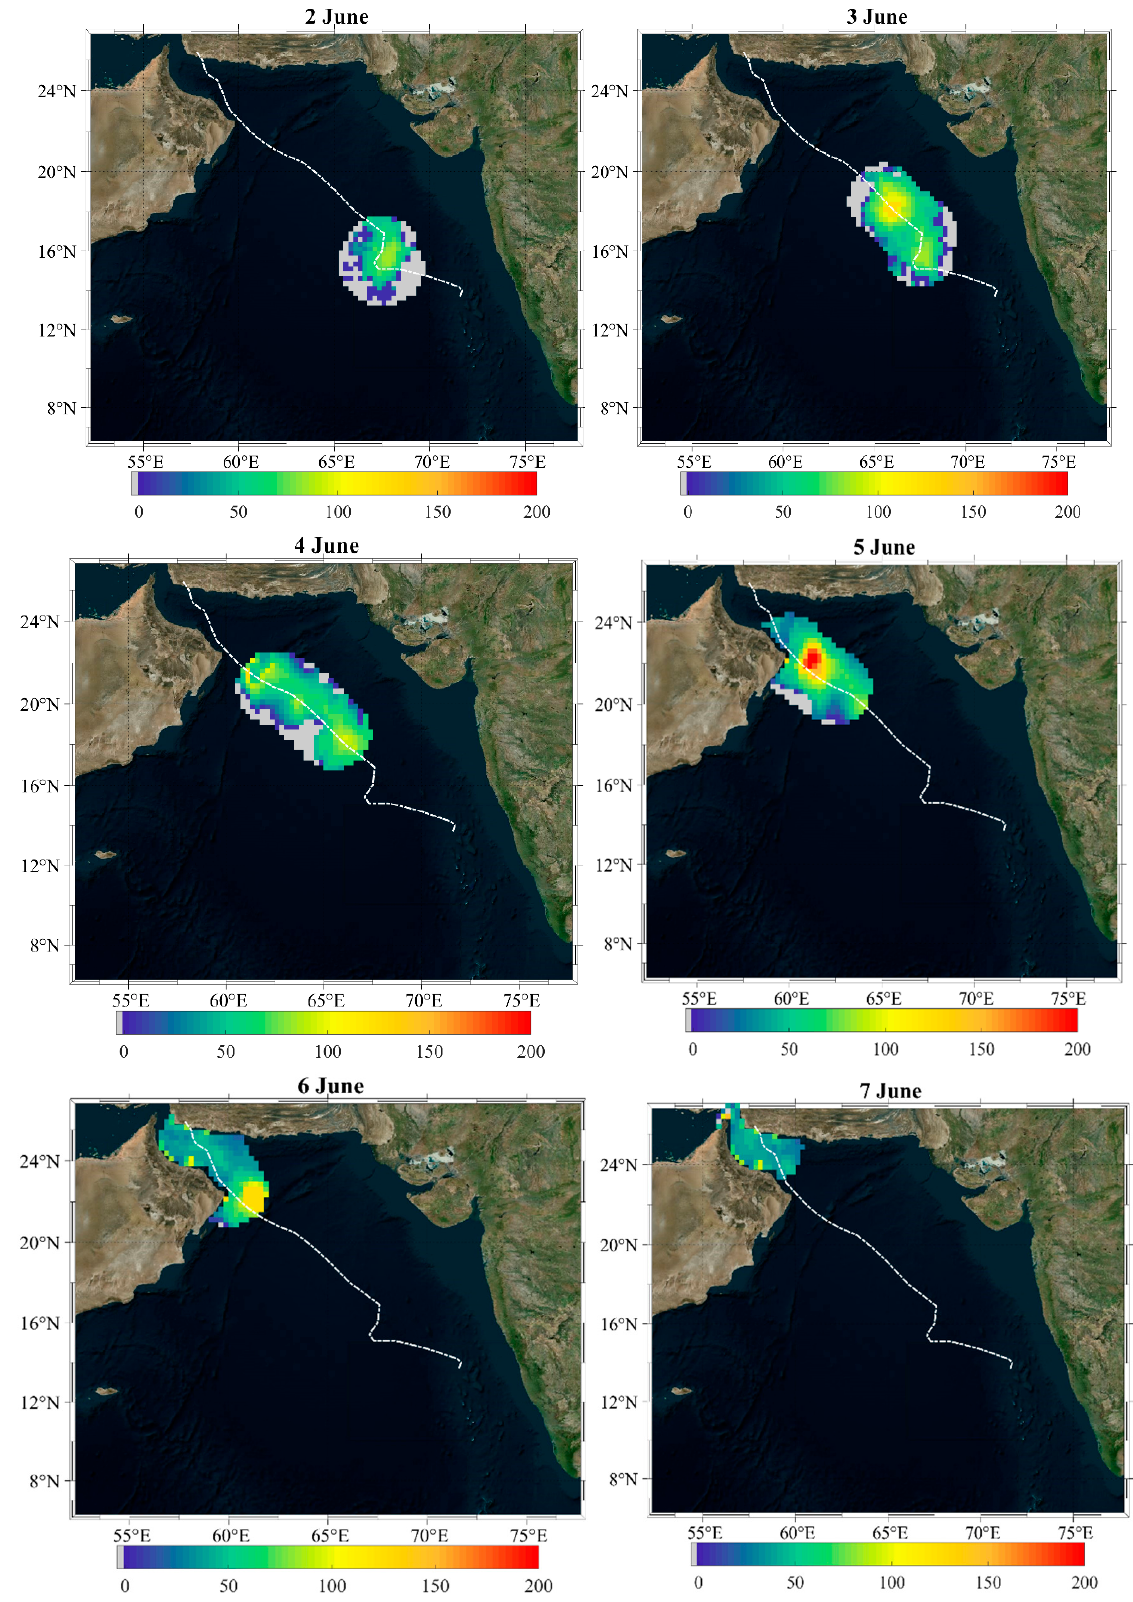
Figure 9. Daily MLD (colors, in m) from 2 to 7 June. Dashed white line is Gonu’s path.